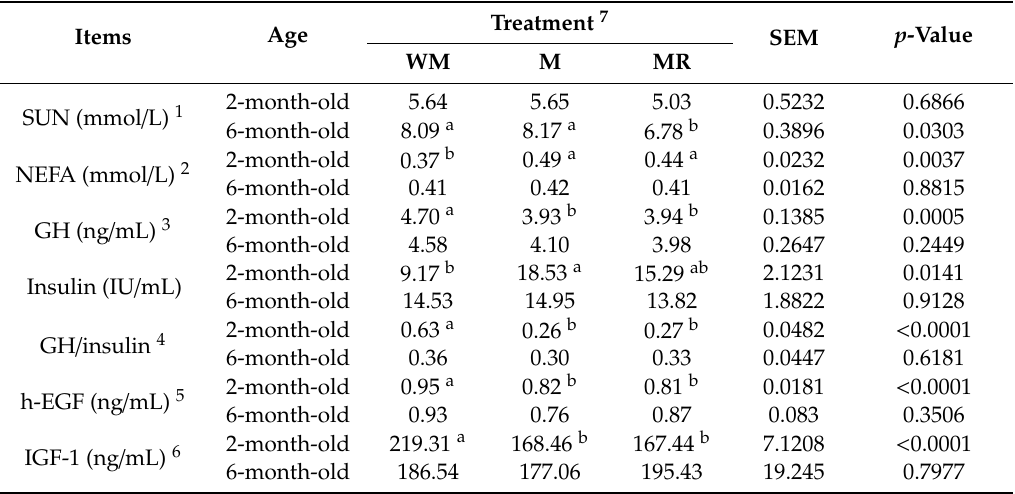
Table 5. Blood metabolites and hormones concentrations of calves at two and six months of age (female, n = 10 per each treatment).